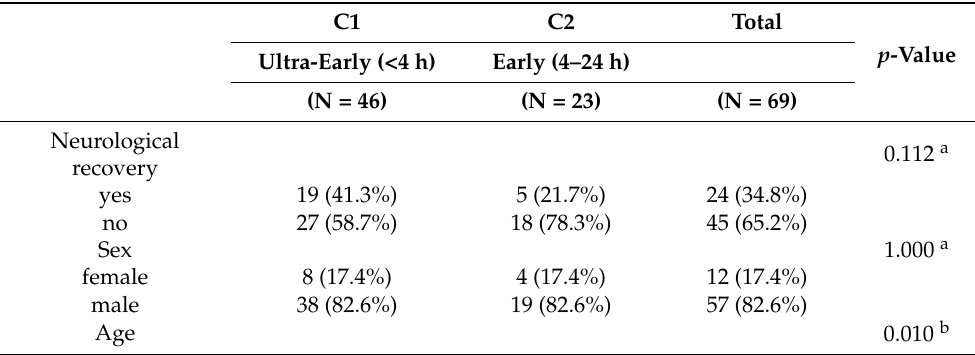
Table 1. Patient demographics of C1 and